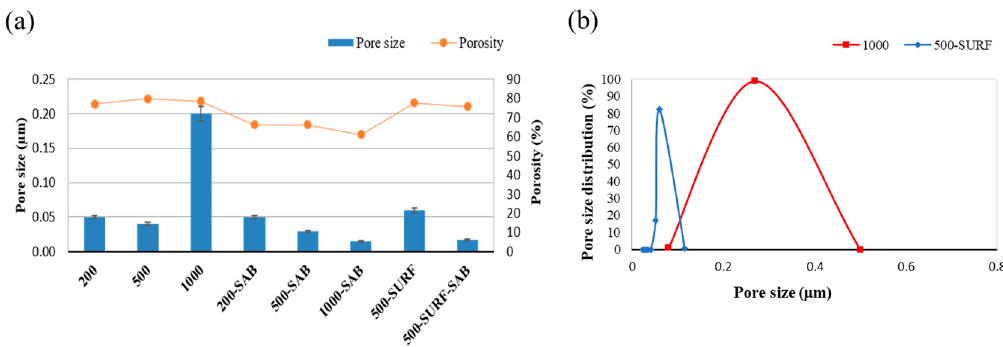
Figure 6. ( a ) Porosity, pore size, and ( b ) pore size distribution of the prepared membranes.